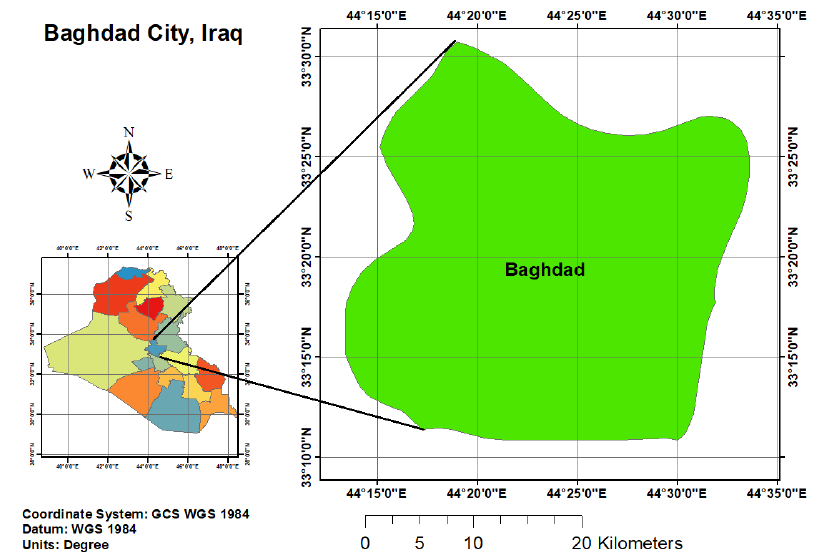
Figure 2. Description of the study area